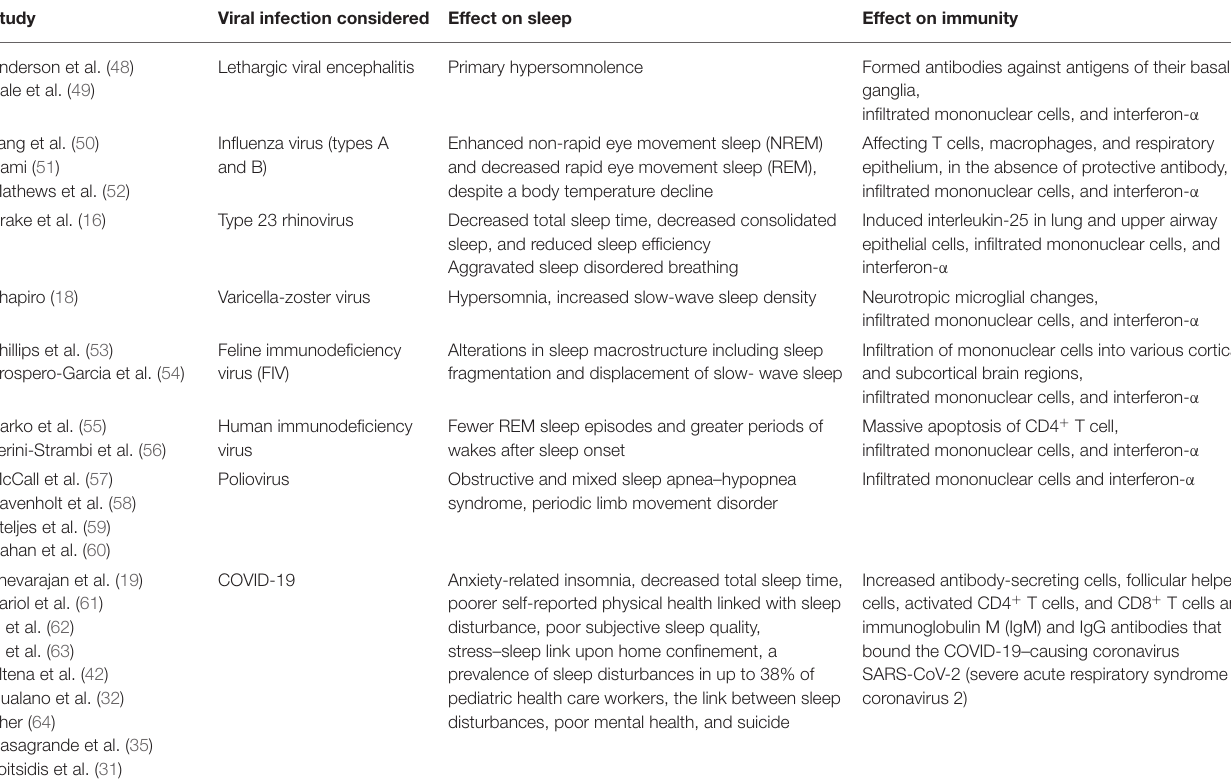
TABLE 1 | An overview on the reciprocal impact of specific viral infections on sleep parameters and innate immunity is summarized.